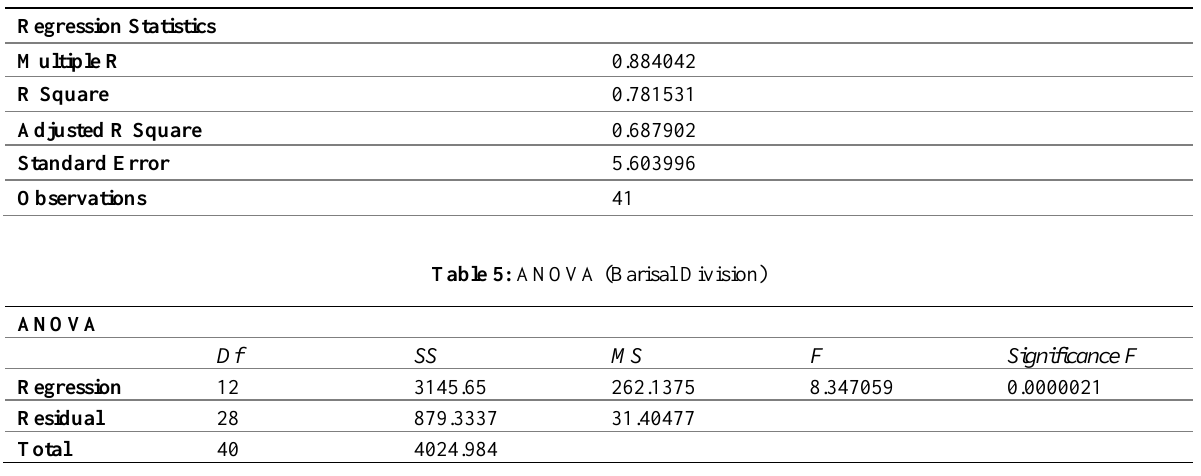
Table 4: Regression Statistics (Barisal Division)